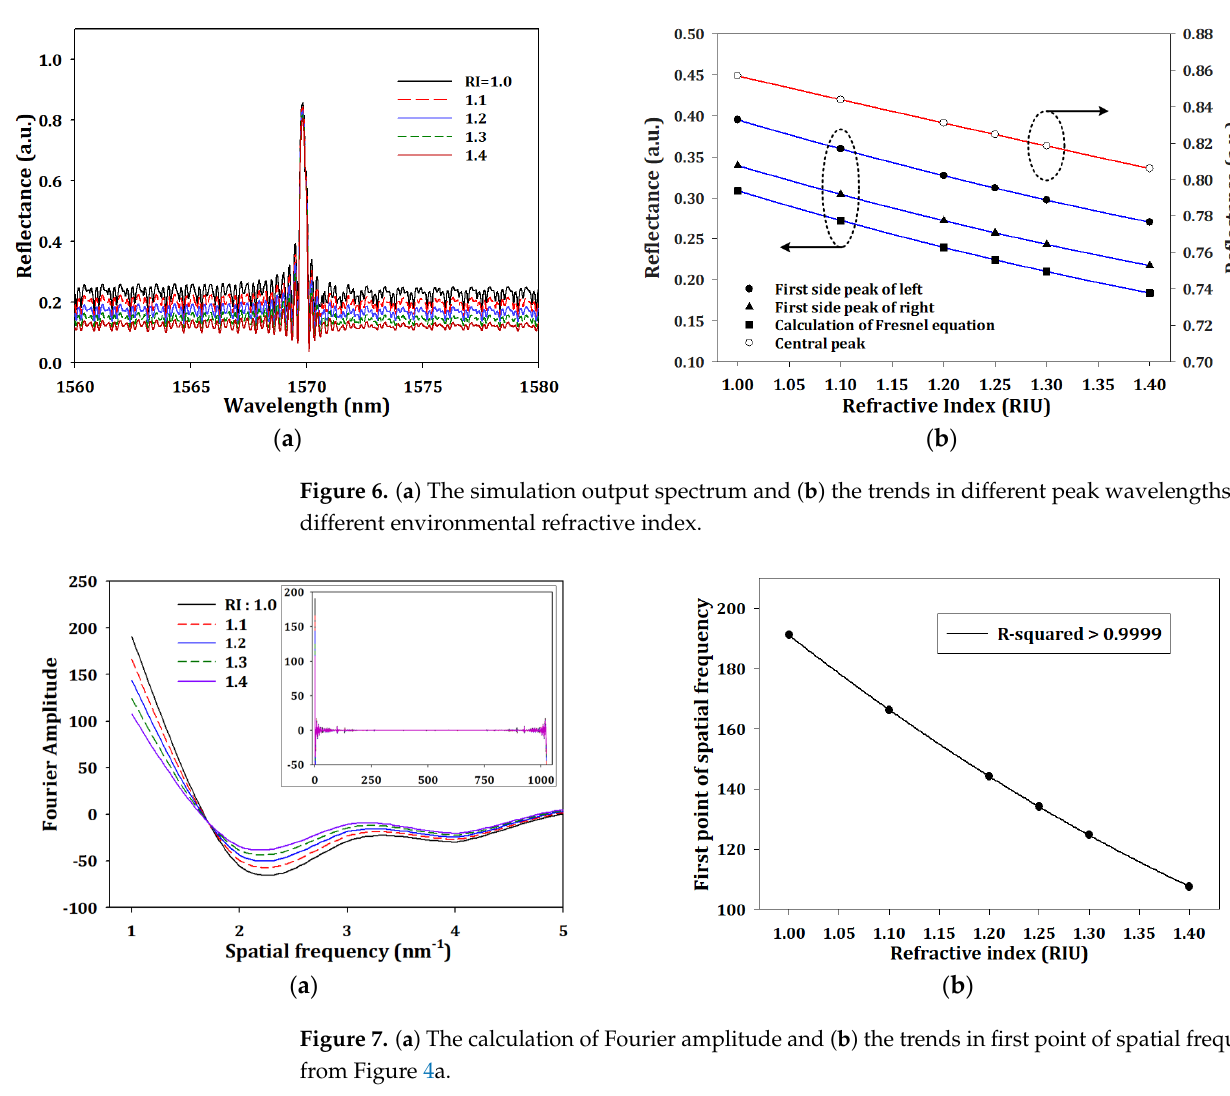
( b ) Figure 5. ( a ) The simulation output spectrum and ( b ) the trends in peak wavelength with different temperature. b.